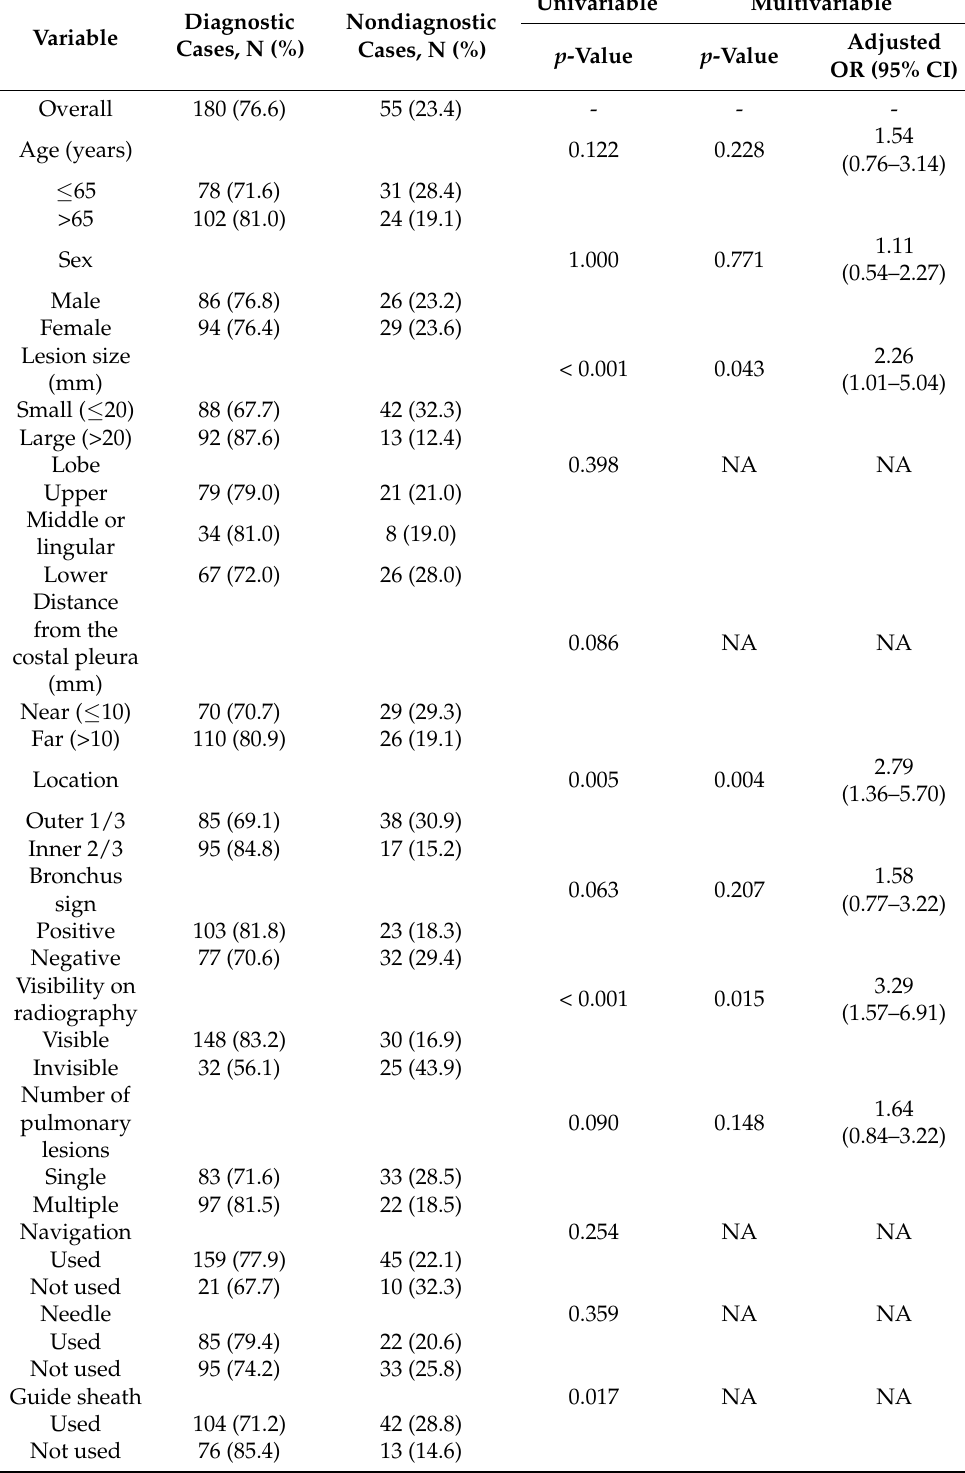
Table 2. Univariable and multivariable analyses of factors associated with diagnostic